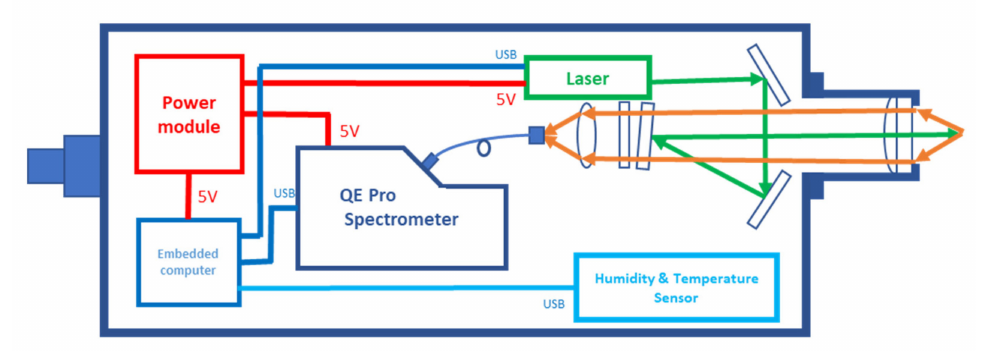
Figure 2. Schematic diagram of the easy-to-operate Raman